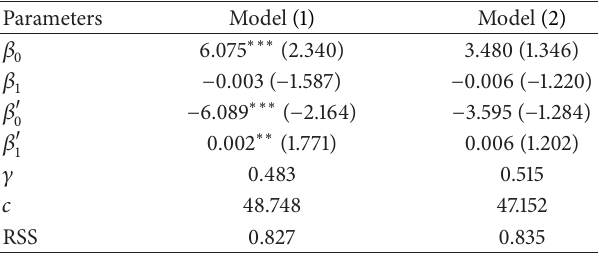
Table 6: PSTR models estimation. Dependent variable: